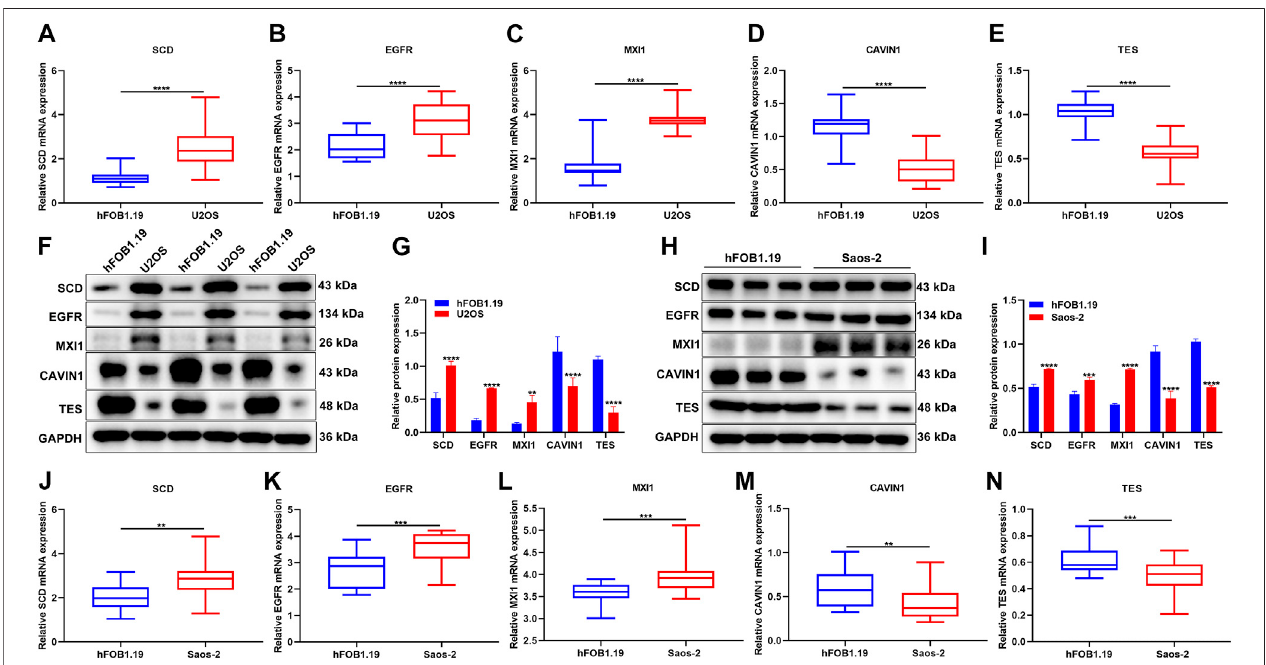
FIGURE11| Veri fi cationoftheexpressionofhypoxicgenesfromthegenesignature. (A – E) RT-qPCRfordetectingtheexpressionofSCD3,EGFR,MXI1,CAVIN1, and TES in U2OS osteosarcoma cells and hFOB1.19 normal cells. (F, G) Western blotting for the expression of the above genes in U2OS osteosarcoma cells and hFOB1.19 normal cells. (H, I) Western blotting for the expression of the above genes in Saos-2 osteosarcoma cells and hFOB1.19 normal cells. (J – N) RT-qPCR for the expression of the above genes in tumors with Saos-2 osteosarcoma cells and hFOB1.19 normal cells. ** p < 0.01; *** p < 0.001; **** p < 0.0001. U2OS osteosarcoma cells compared with hFOB1.19 normal